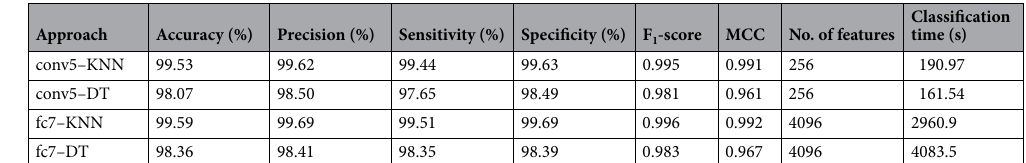
Table 6. Performance of the hybrid approach using the deep features without feature selection.